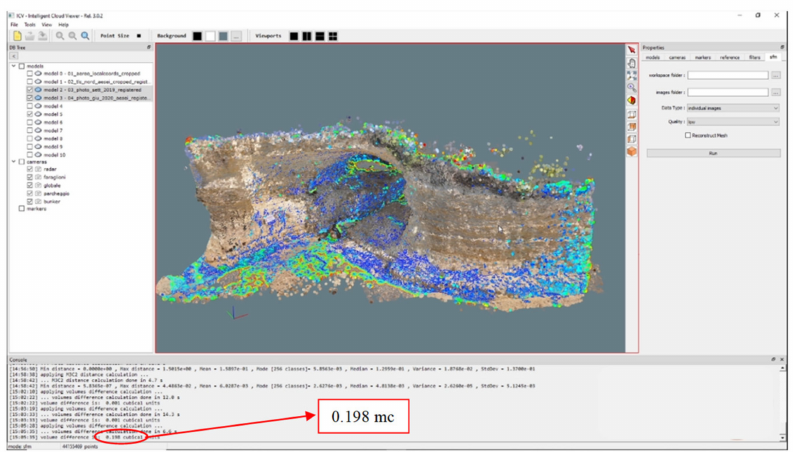
Figure 21. Calculation of volume difference in ICV